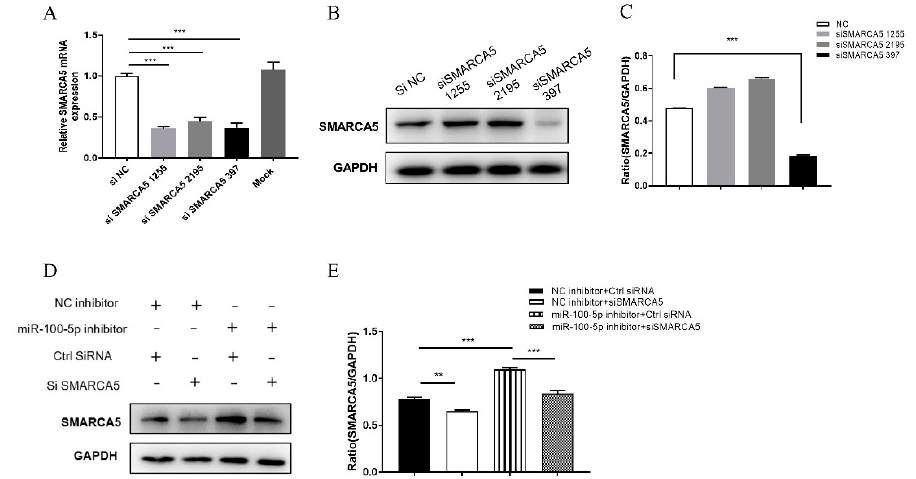
Figure 7. Construction of miR-100-5p and siSMARCA5 cotransfection model. ( A – C ) After transfection of three siRNAs, SMARCA5 mRNA and protein expression levels were detected by qRT-PCR and Western blotting. The protein expression ratios were analyzed using ImageJ with normalization to GAPDH. ( D ) Western blot detected SMARCA5 protein expression from THP-1 cells pretreated with miR-100-5p inhibitor, siSMARC5 and their negative controls infected with BCG. ( E ) Expression ratios analyzed using ImageJ with normalization to GAPDH. Data are from three independent experiments with biological duplicates in each (( A ); mean ± s.e.m. of n = 3 duplicates) or representative of three independent experiments (( B – E ), mean ± s.e.m). ** p < 0.01; *** p < 0.001. Based on the SMARCA5 interference model, LDH release assay, flow cytometry,